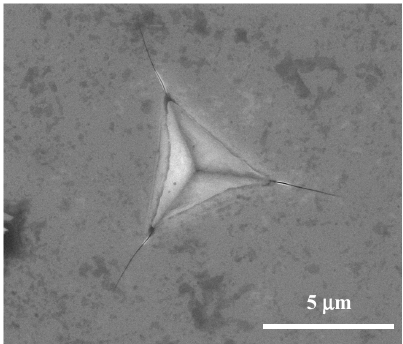
Figure 1. Scanning electron microscope image of surface-breaking cracks and associated directions from a 150 mN Berkovich indent with the indenter apex parallel to [011].